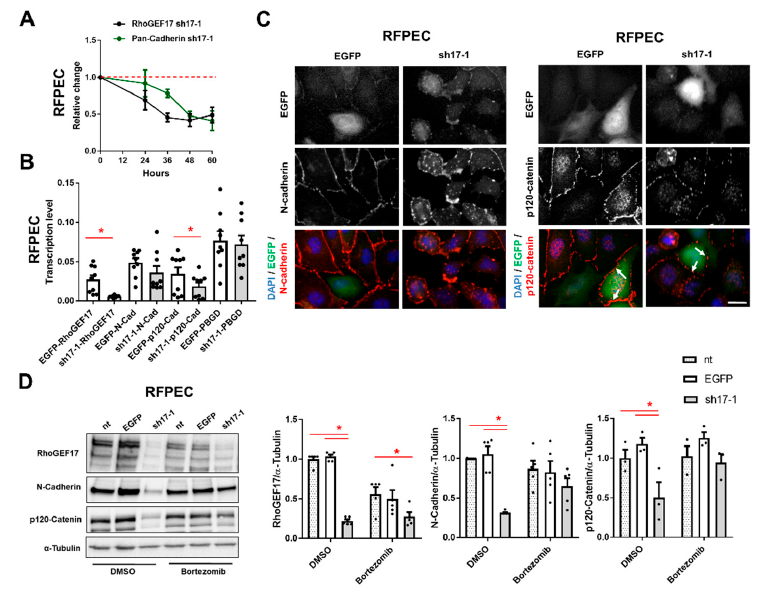
Figure 2. Loss of RhoGEF17 results in the proteasomal degradation of AJ proteins in RFPEC. RFPEC were transduced with adenoviruses encoding EGFP (EGFP), or EGFP and a shRNA against RhoGEF17 (sh17-1). ( A ) Immunoblot analysis of RhoGEF17, pan-cadherin and α -tubulin was performed at the indicated time points. The values were normalized by α -tubulin and are given as means ± SEM relative to the time point 0 h, n = 3–21. ( B ) Immunofluorescence analysis was performed 48 h after transduction. Depicted are EGFP images, immunofluorescence staining of N-cadherin (left), p120- catenin (right) and the overlays with DAPI. Scale bar = 20 µ m. ( C ) The transcript levels of RhoGEF17, N-cadherin, p120-catenin and the housekeeping gene PBGD were determined by qPCR after 48 h of transduction. The values are given as means + SEM with the single data points, n = 9, * p < 0.05 assessed by paired t-testing. ( D ) The proteasome was inhibited with 100 nM Bortezomib for 2 h. Non-transduced (nt) cells were used as additional control. RhoGEF17, N-cadherin and p120-catenin were detected by immunoblot in whole cell lysates. Shown are representative immunoblots of RhoGEF17, N-cadherin, p120-catenin and α -tubulin (left) and the quantitative analyses. Values were normalized by α -tubulin and are given relative to non-transduced cells treated with DMSO only. Shown are means + SEM and the single data points; n = 3–5, * p < 0.05 assessed by 2-way ANOVA with Tukey’s multiple comparison